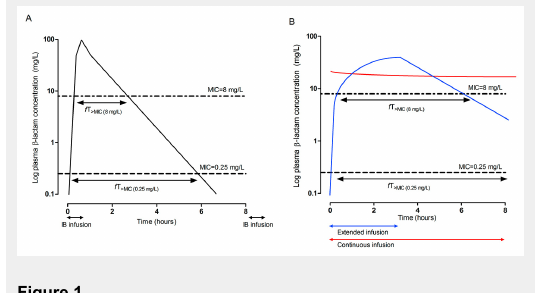
Differences in the time that β-lactam concentrations exceed the MIC ( f T >MIC ) of two different pathogens (MIC of 0.125 mg/l and 8 mg/l, respectively) according to the mode of β-lactam administration. (A) Intermittent bolus administration. (B) Extended infusion (blue line) and continuous infusion (red line). IB = intermittent bolus administration; MIC = minimal inhibitory concentration; f T >MIC = time that the free drug concentration is above the